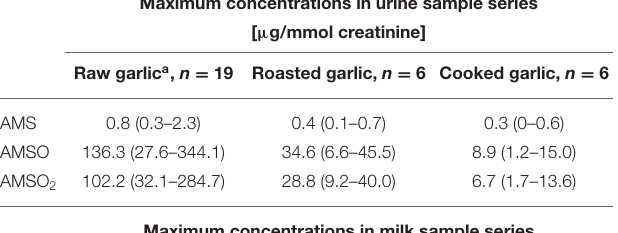
TABLE 1 | Average (range) of maximum metabolite concentrations detected in urine and milk samples after ingestion of raw, roasted, and cooked garlic. Maximum concentrations in urine sample